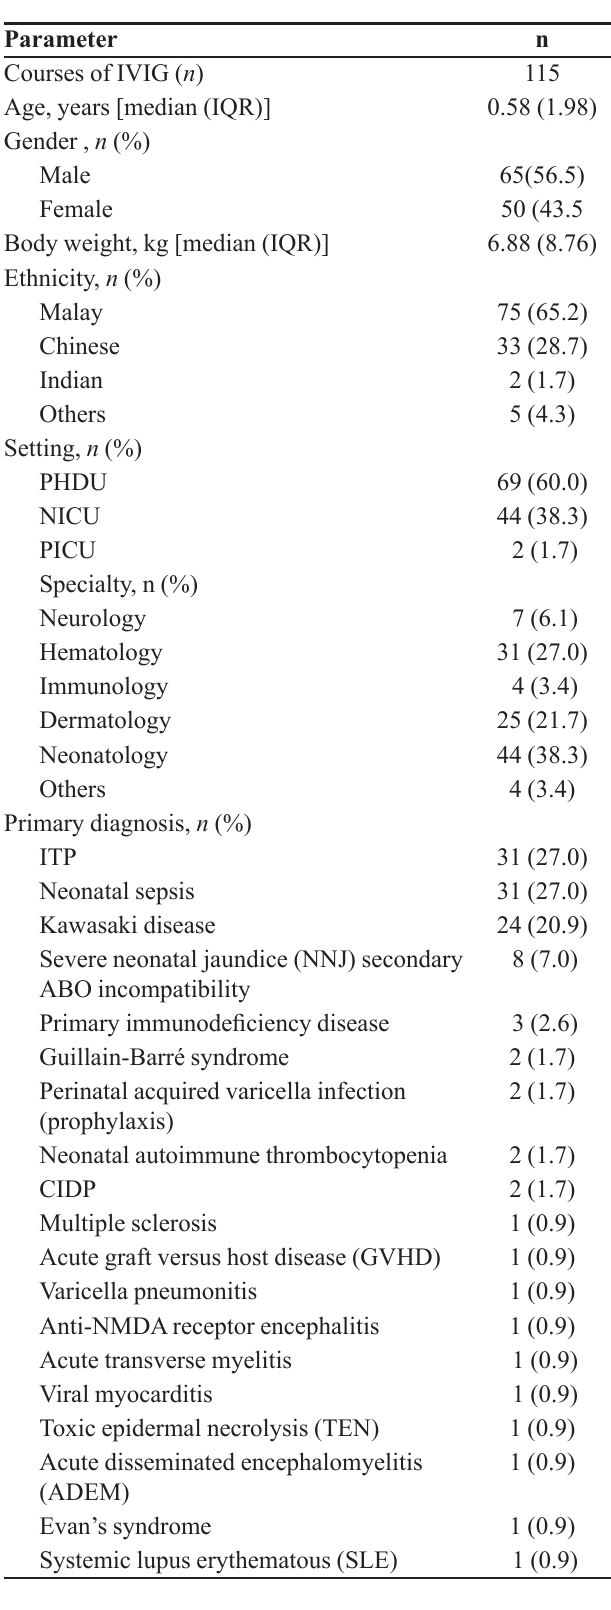
TABLE I – Patient demographics and clinical data